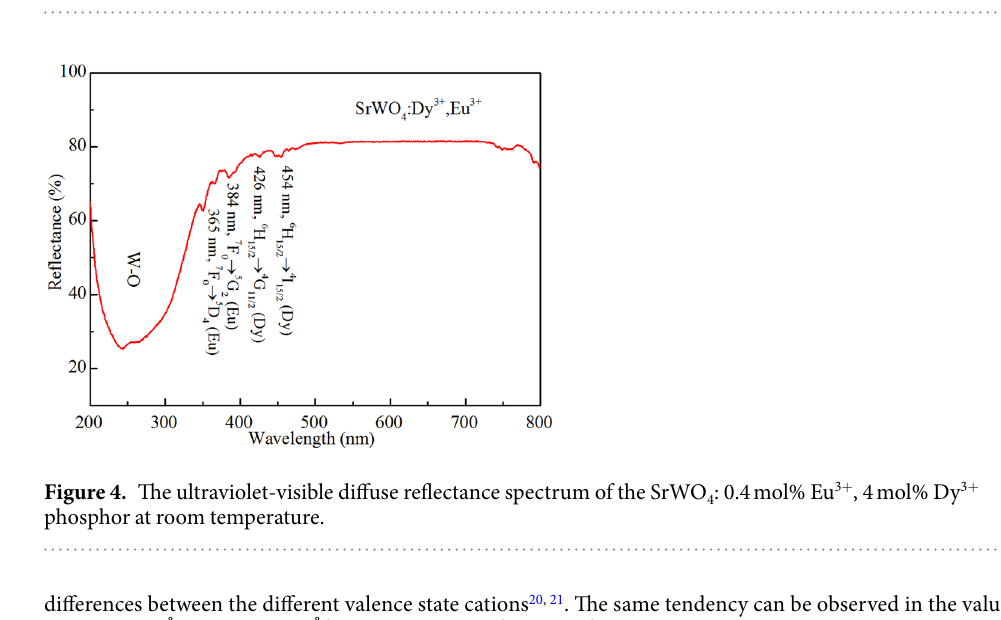
Figure 3. ( a ) SEM and ( b ) EDS images of the Eu 3 + /Dy 3 + co-doped SrWO 4 phosphor.